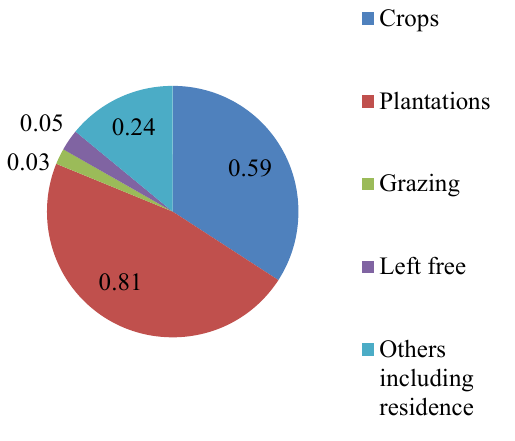
Figure 1. Mean land holding and cover of